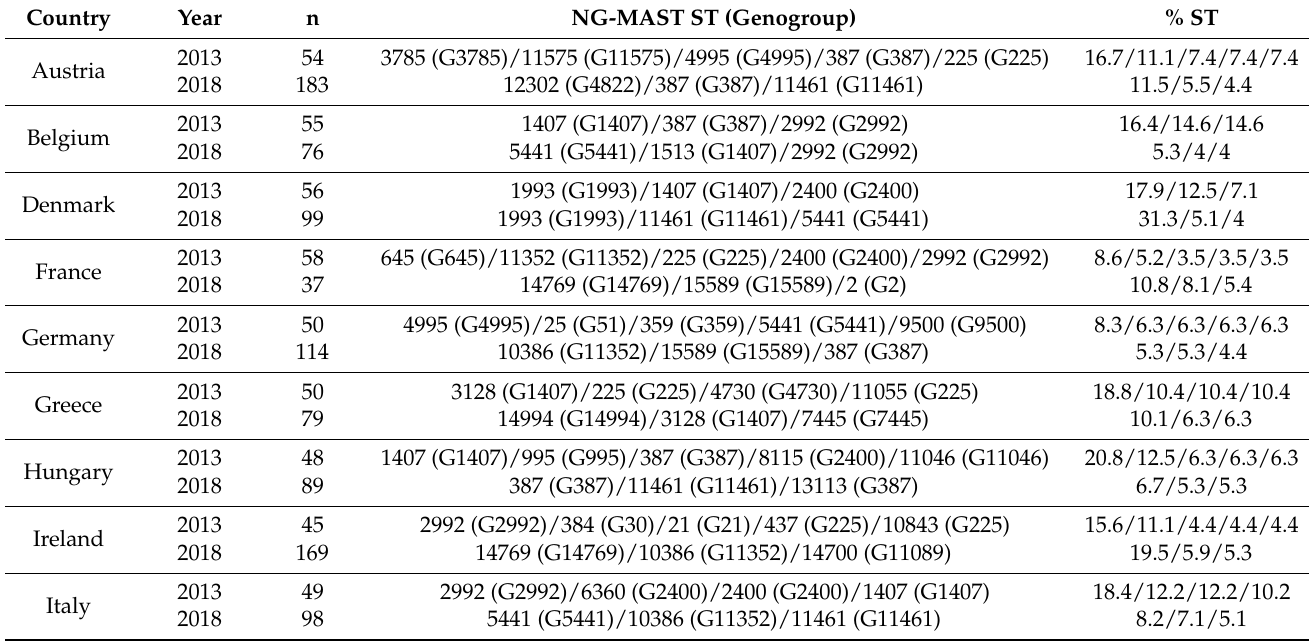
Table 5. Prevalence of NG-MAST sequence types in Europe and selected non-European